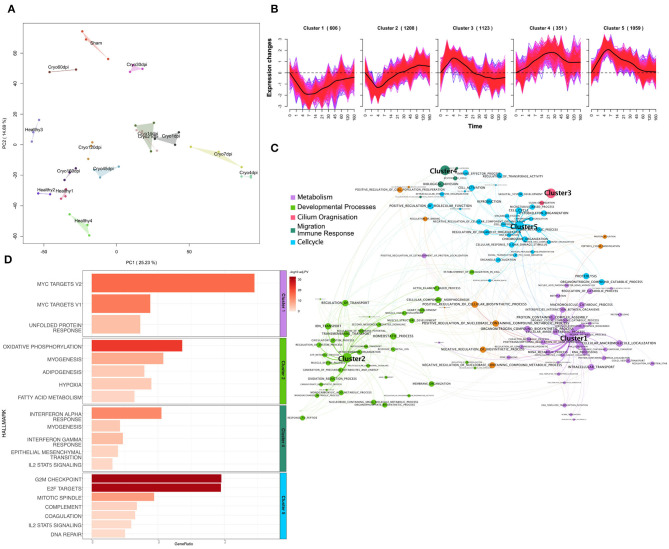
(A) Principal component analysis plot of log2-expression (counts per million) of mRNA samples of the zebrafish data. Each color represents a different condition. (B) Soft-clustering of log2FC of the zebrafish data over time. Black lines visualize the average dynamics of the clusters. (C) Gene Set Enrichment Analysis (Fisher's Test) of genes from every cluster of gene ontology biological processes. Gene sets are connected by an edge if they share 40% of genes. Terms are connected to the clusters based on their p-value. Size of the nodes is anticorrelated to the p-value. (D) Bar plot of Gene set enrichment analysis (Fisher's Test) of genes from every cluster for Hallmarks of Cancer. The gene-ratio represents the number of regulated genes in the relation to the gene set size. Gene-ratio of genes regulated within each term divided by the total number of genes within the respective term. Color coded bar depicts the –log10 adj. PV (FDR).